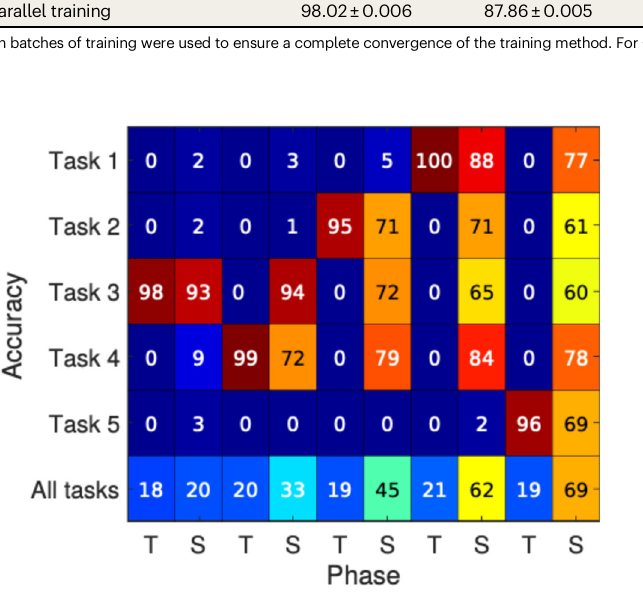
Fig.2|Interleavingnewtasktrainingwithsleepresultsinrecoveryofoldtasks ’ performanceonMNISTdataset. Sleepphase(S)wasimplementedaftereachnew task training (T). Task 1 – 0/1, Task 2 – 2/3, Task 3 – 4/5, Task 4 – 6/7, Task 5 – 8/9. Each column shows performance for all tasks after either new task training or sleep as labeled